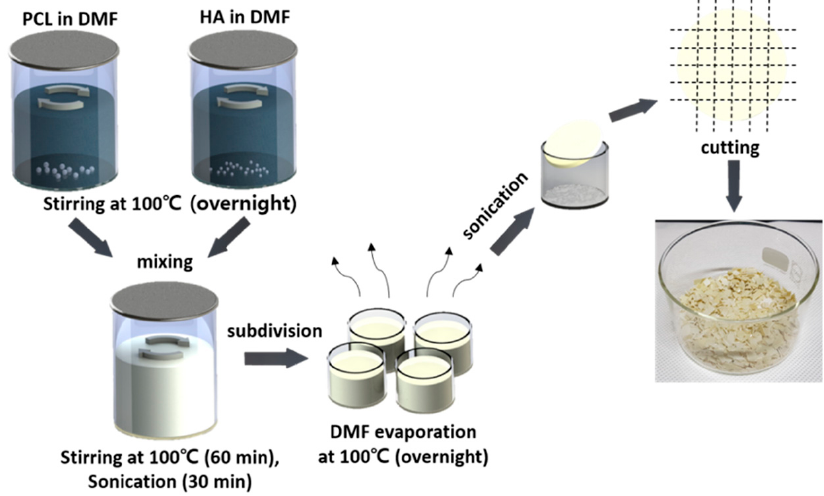
Figure 1. Schematic of the PCL/HA composite flake preparation steps. Photograph showing the PCL/HA composite flakes after evaporating the solvent from the composite solution.